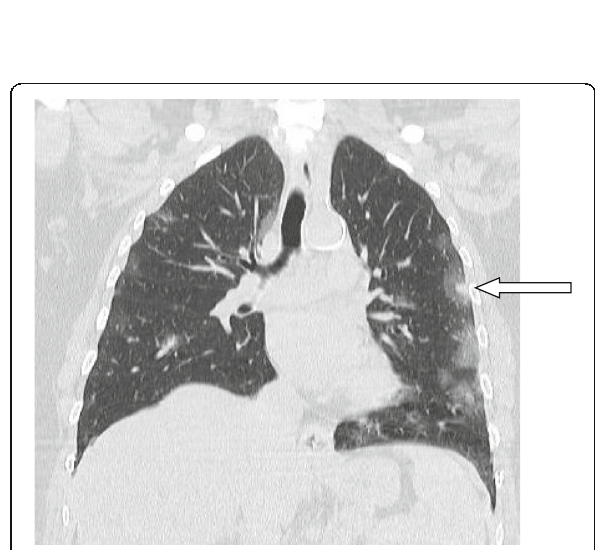
Fig. 14 Patient with COVID-19 pneumonia with multiple peripheral areas of GGO. Halo sign is seen in the left